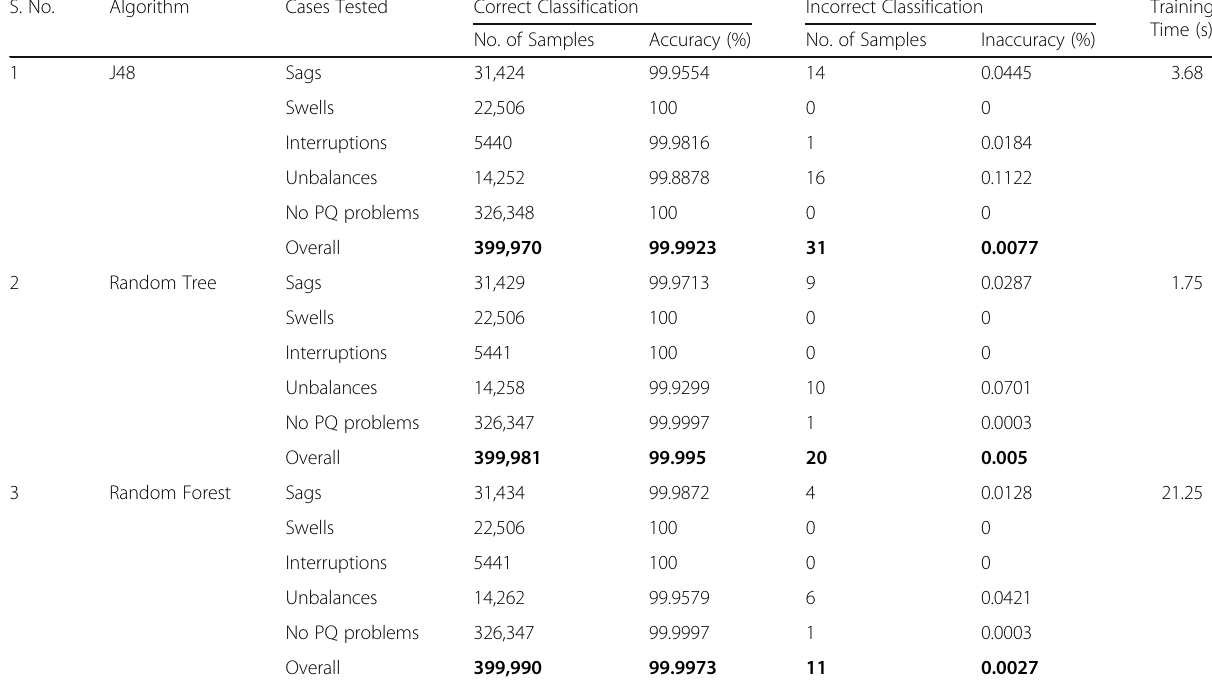
Table 5 Comparison of Data Mining Algorithms with 7 attributes for stratified 10-fold cross-validation S.